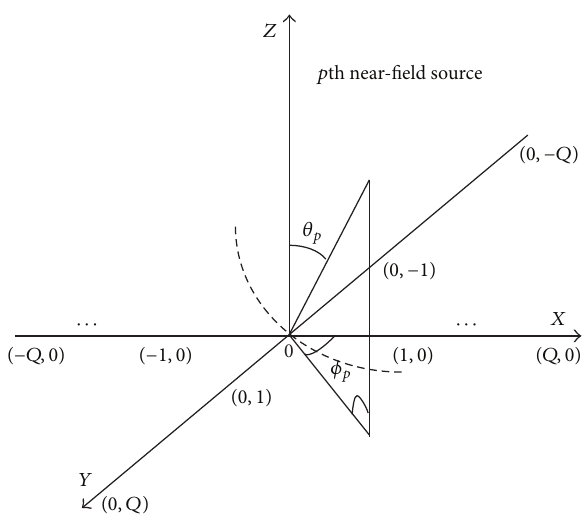
Figure 1: Signal model for near-field